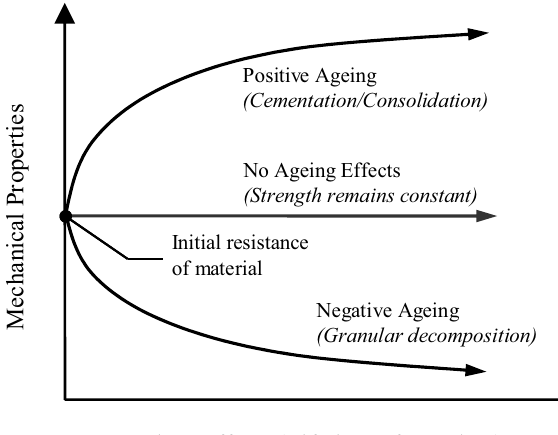
Fig. 1. Time-dependent behaviour of granular soils.